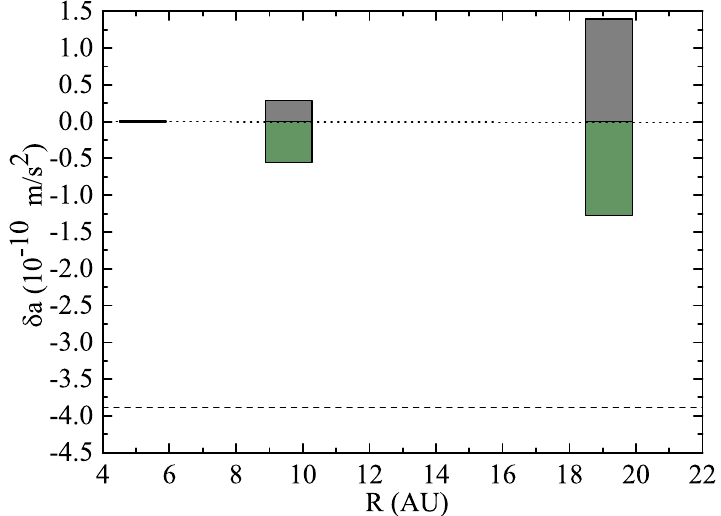
Figure 6. Anomalous accelerations as a function of the distance from the Sun as predicted for the model in Equation (22). The dashed line corresponds to n = 2 and the dotted one to n = 3. The parameter β (cid:39) 8737 AU is the same in both cases. The bars give the maximum positive (green) and the minimum negative (grey) anomalous accelerations acting on Jupiter, Saturn, and Uranus as deduced from the ephemeris of Pitjeva et al.